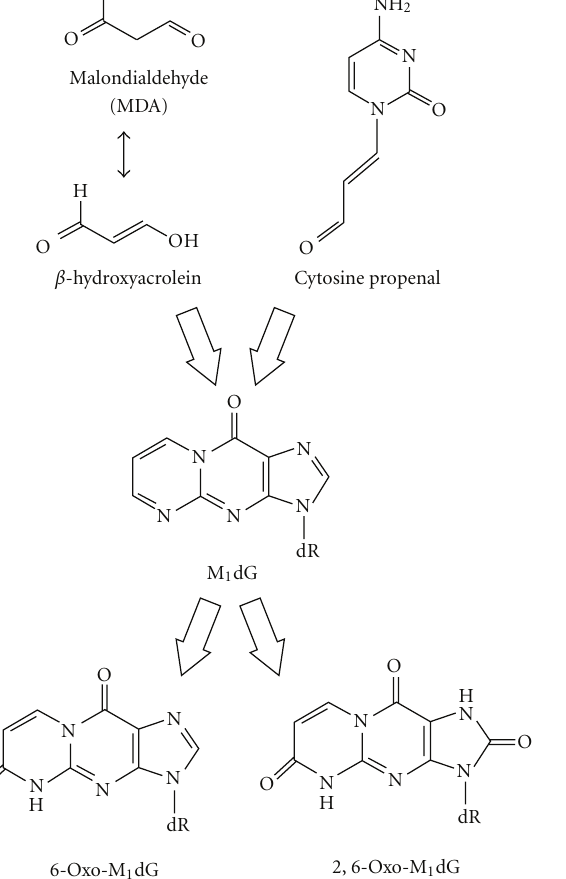
Figure 4: Formation and metabolism of M 1 dG.